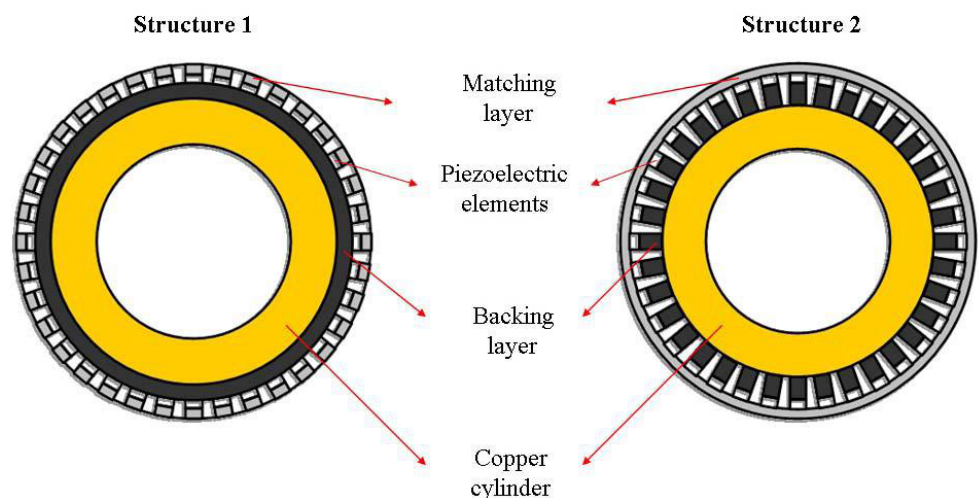
Figure 21. Cross-sectional schematic diagrams of PMN-PT endoscopic ultrasonic radial arrays (with permission from [85]).